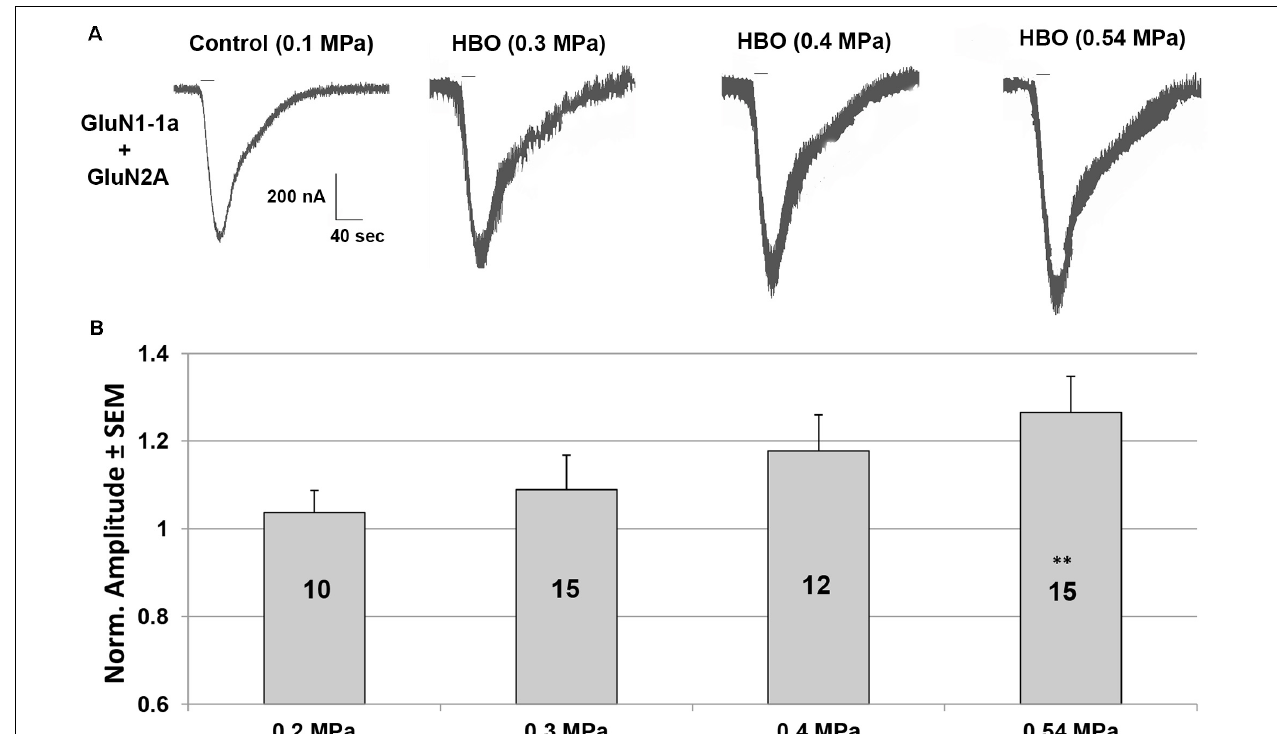
FIGURE 1 | Current amplitudes of the GluN1-1a + GluN2A subtype in HBO at different pressures. (A) An example of HBO effects on GluN1-1a + GluN2A current response. All pressure steps were applied to the same oocyte. The applied agonists were glutamate (100 µ M) and glycine (10 µ M) with no [Mg 2 + ] o added. The 20 s agonists application time is indicated by horizontal bars. (B) Quantitative analysis of the NMDAR currents. Responses were normalized to the control value at 0.1 MPa (when the recording solution is saturated with 100% O 2 ) for each tested oocyte (indicated by numbers in the bars). Oocytes were exposed to 2–4 increased pressure steps. ∗∗ p <